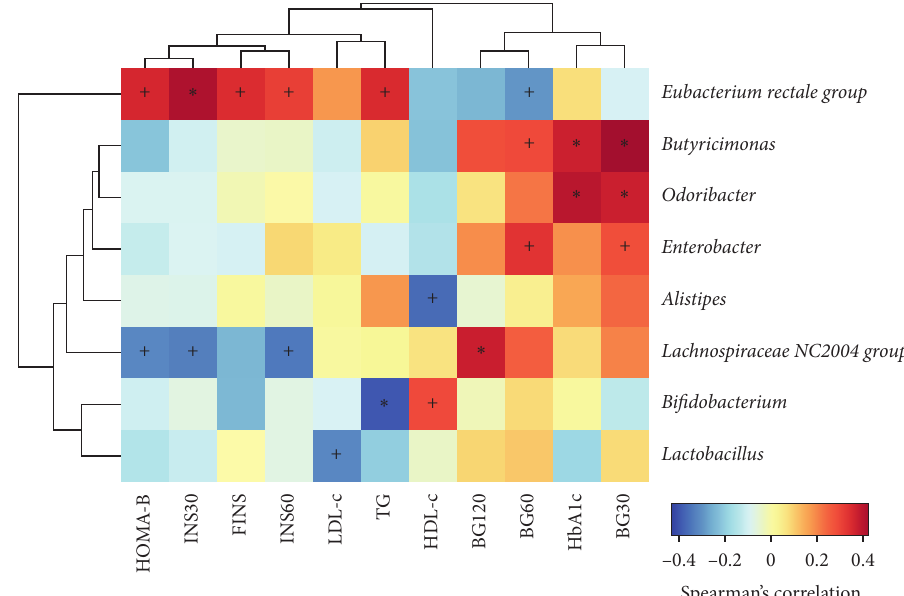
Figure 5: Heat map showing spearman correlations between different gut microbiota at the genus level and glucose and lipid metabolic parameters. ∗ P < 0 . 05, + q ＜